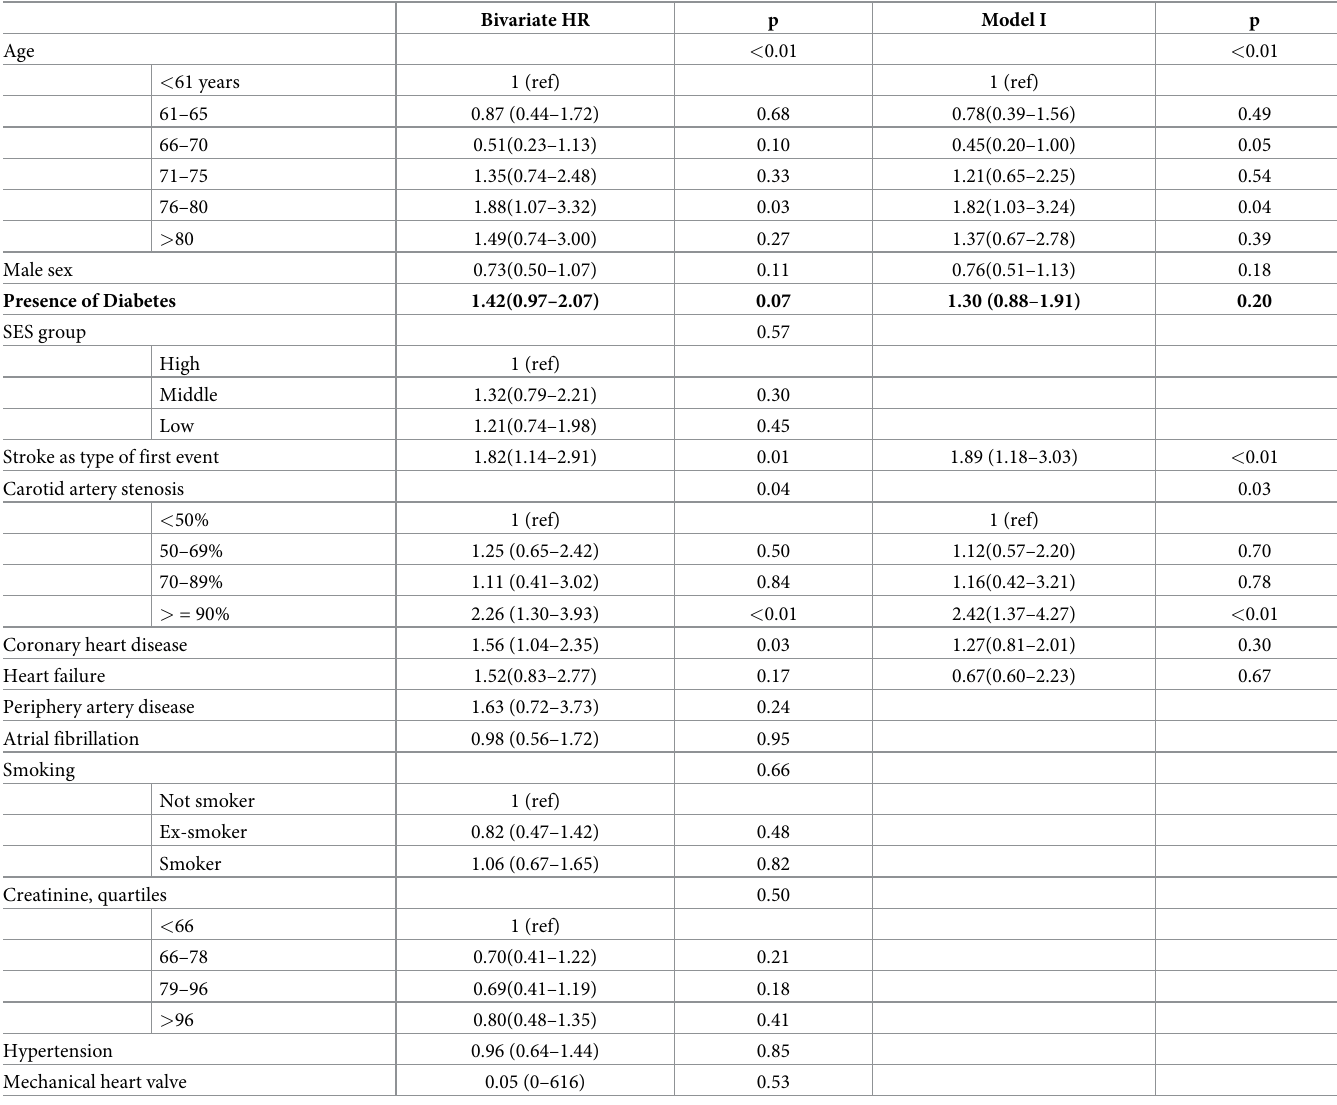
Table 4. Cox proportional hazards model in all subjects with recurrent stroke as